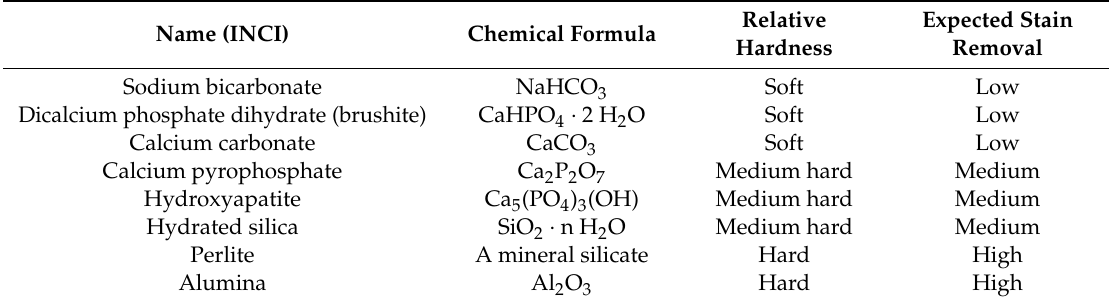
Table 2. Overview of commonly used abrasives in toothpastes [47]. Hard abrasives remove stains more e ffi ciently than soft abrasives; however, they may be harmful to the enamel and specially to exposed dentin (INCI: International Nomenclature of Cosmetic